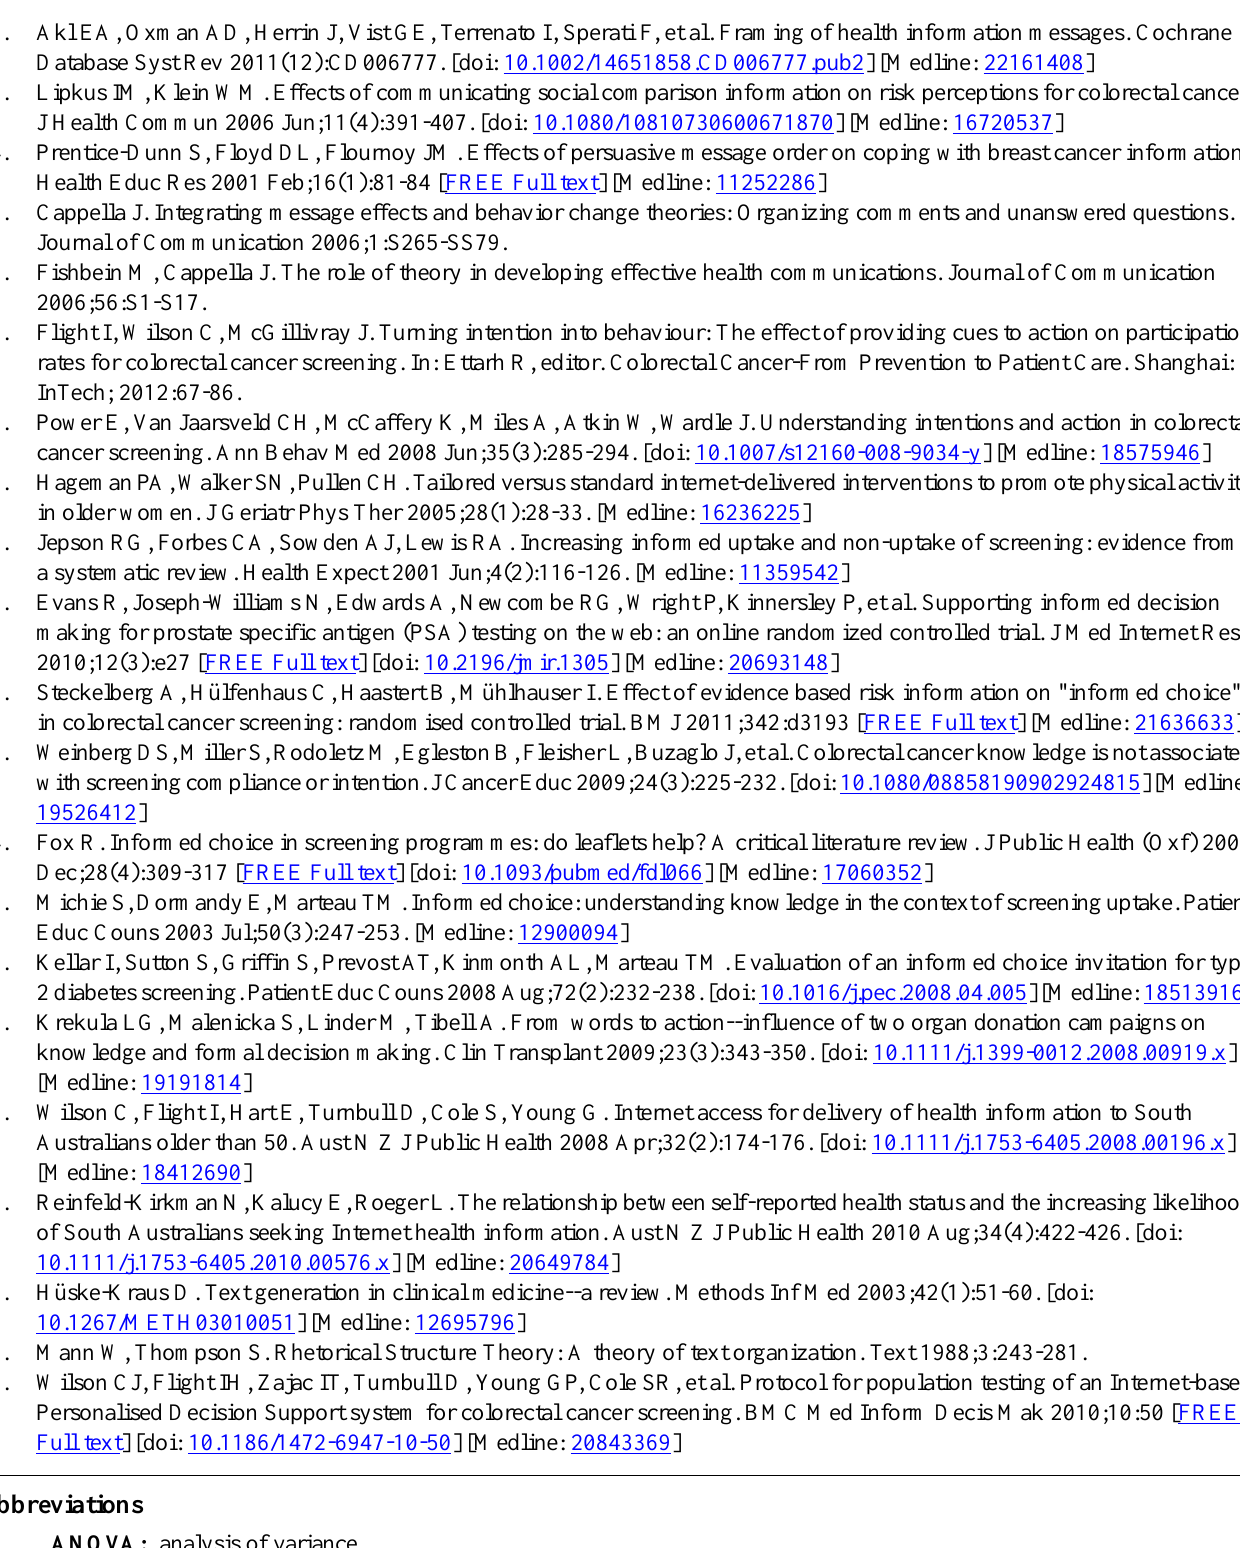
Abbreviations ANOVA: analysis of variance CATI: computer-assisted telephone interview CRC: colorectal cancer CSIRO: Commonwealth Scientific and Industrial Research Organisation FIT: fecal immunochemical test FOBT: fecal occult blood test iFOBT: immunochemical fecal occult blood test NBCSP: National Bowel Cancer Screening